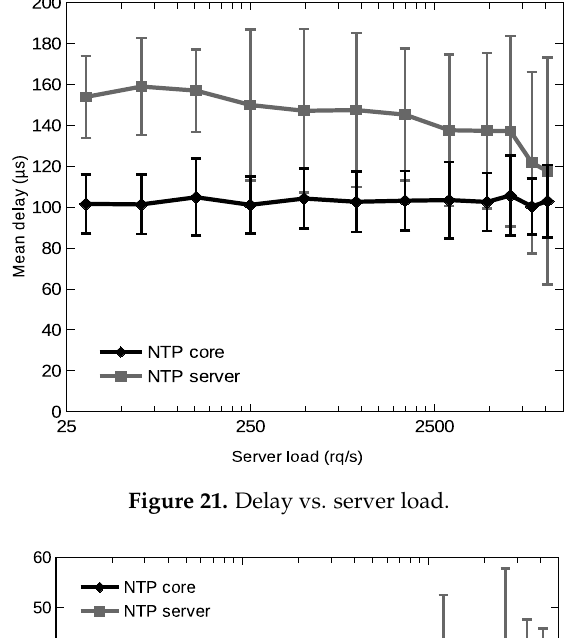
Figure 21. Delay vs. server load.